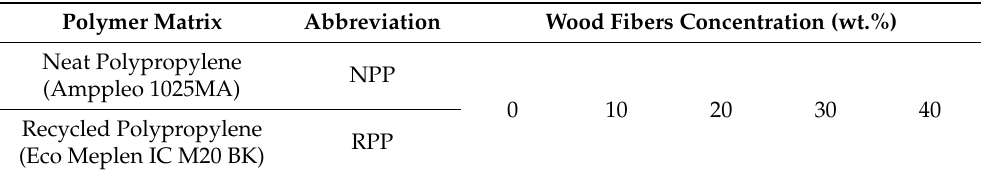
Table 1. Nomenclature and sample material